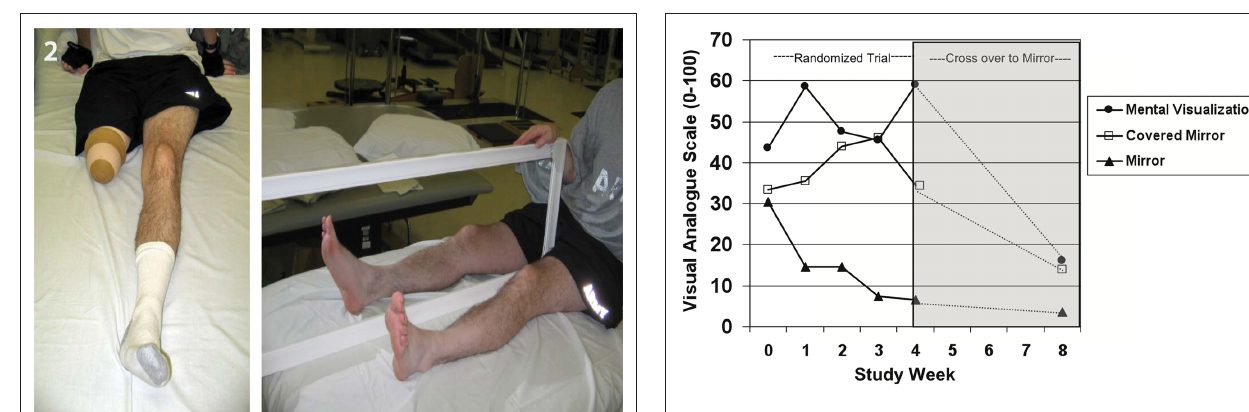
Frontiers in Neurology |